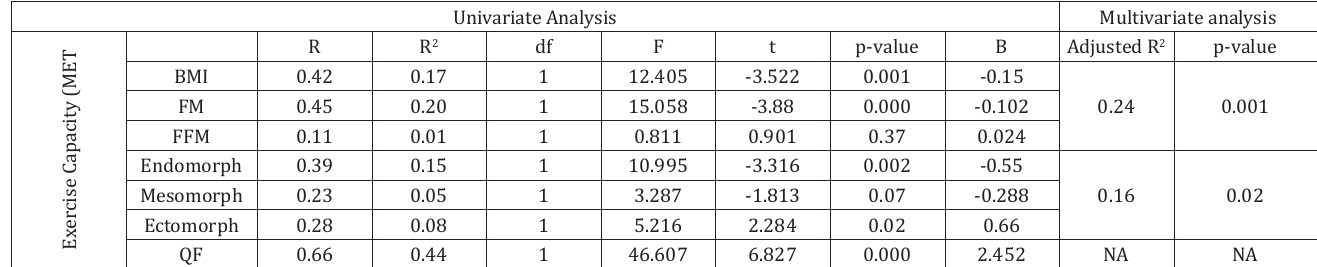
Univariate and Multivariate Regression Analyses on Exercise Capacity, Somatotype Components, Body Composition, and Quadriceps